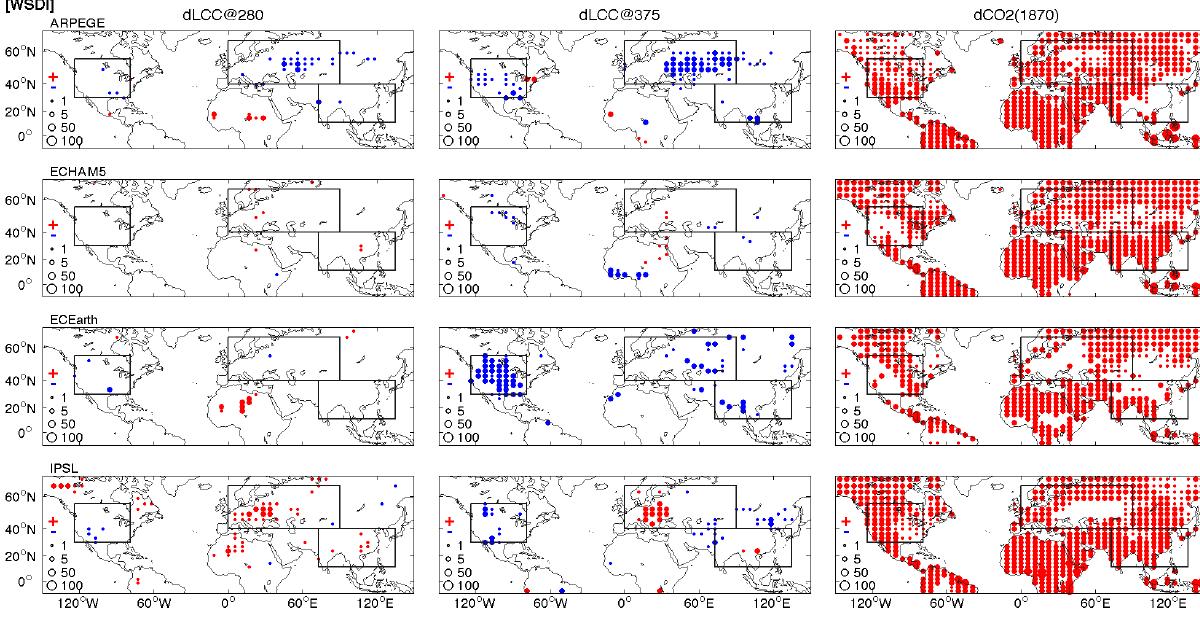
Fig. 7. As Fig. 4 but for the warm spell duration index (WSDI, daysyr − 1 ).